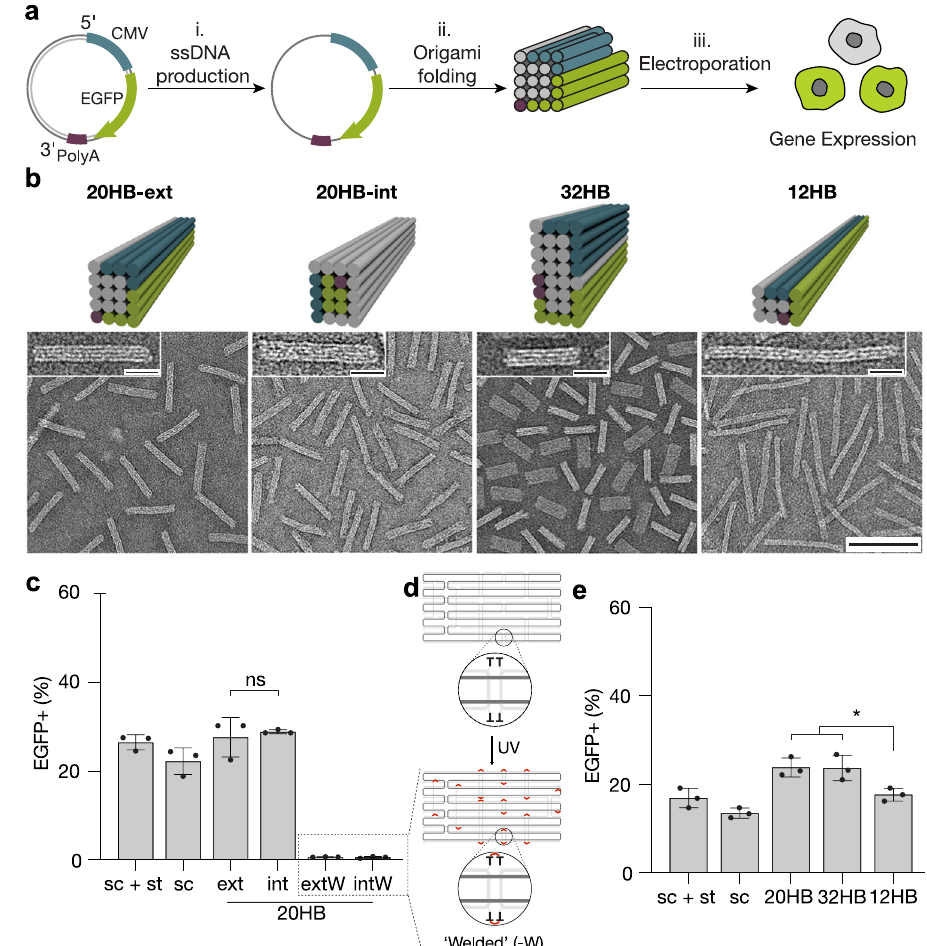
Fig. 1 | Folding and expressing genes from origami structures. a Schematics of the overall work fl ow:ssDNAisproduced from plasmidDNA viaphagemids (i),and then folded into 20 helix bundle (20HB) DNA origami objects (ii). Objects were delivered to cells, and geneexpression fromthe origamistructurewasassessed by detection ofpositive fl uorescence read-out (iii). CMV promoter sequenceisshown inblue,geneencodingforenhancedgreen fl uorescentprotein(EGFP)ingreen,and the bGH polyadenylationsignal(polyA) inpurple. b Cylinder modelsand negative- staining transmissionelectronmicrographsofthe20HB,12HBand32HBaregiven in the upper and lower panels, respectively (scale bar 100nm, insets 20nm). Col- oring demonstrates the positions of the scaffold features, for example 20HB-ext demonstrates the CMV (blue), EGFP (green) and polyA (purple) encoding sequen- cespresentalongexteriorhelices,while20HB-intpresentsthesequencesencoding for EGFP and polyA within interior helices. c Transfection ef fi ciency in